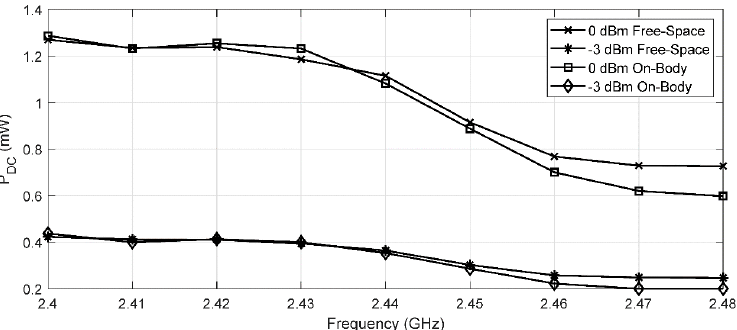
Figure 18. 2 × 2 rectenna output DC power P DC vs. frequency measurements in free-space and on- body.